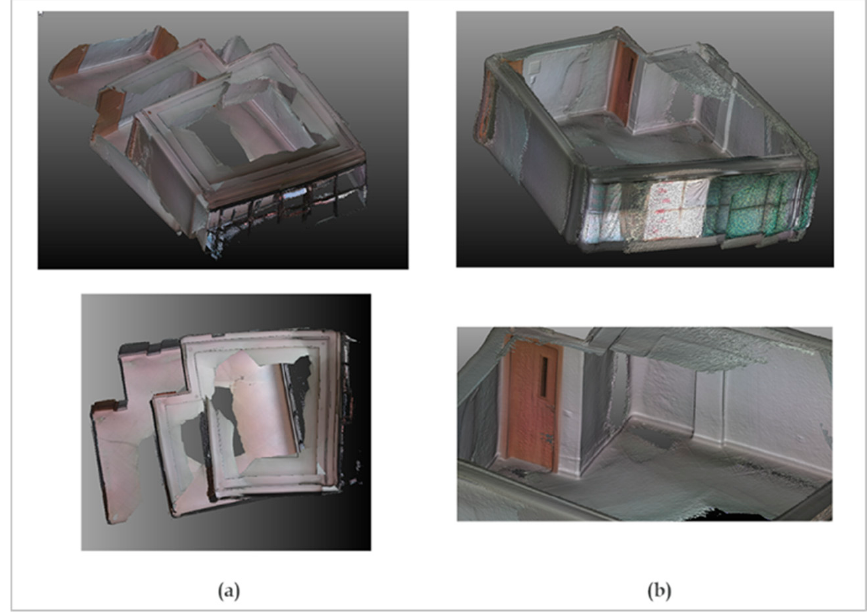
Figure 15. Results of indoor 3D reconstruction of the office scene. ( a ) by keeping the windows uncovered; ( b ) by covering the windows.